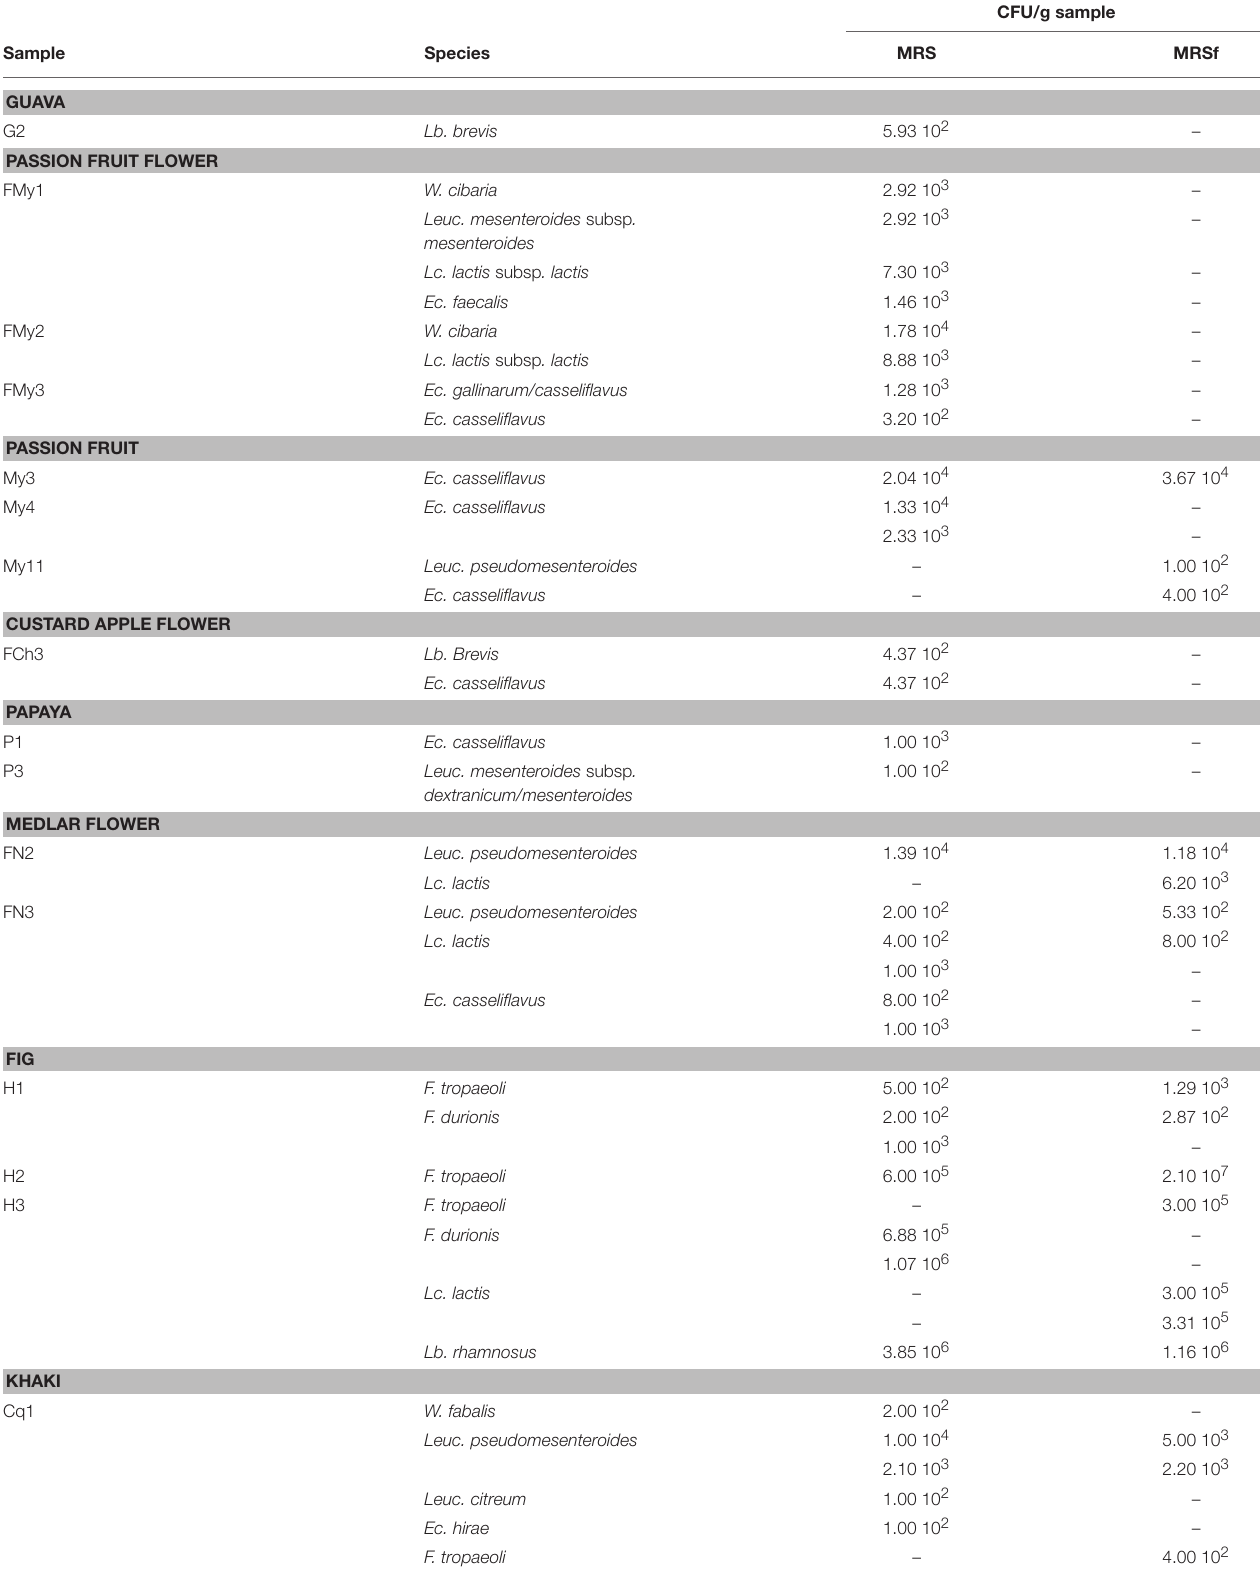
TABLE 4 | Microbial load of each LAB species present in the fruits and flowers assayed, as grown in MRS and MRSf incubated at 30 ◦ C for